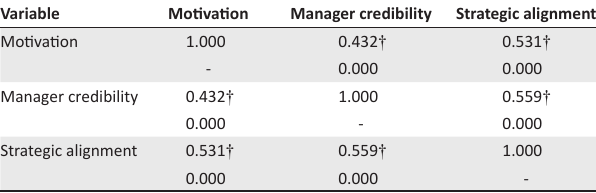
TABLE 1: Spearman’s correlation coefficient on motivation, strategic alignment and manager credibility ( N = 3112). Variable